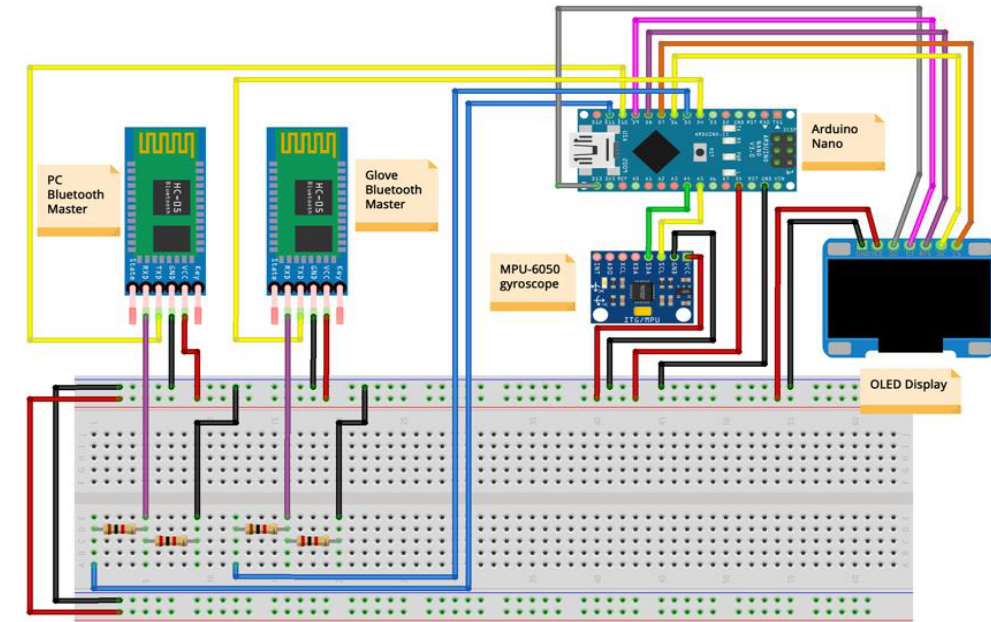
Figure 6. Tech glove wiring schematic.